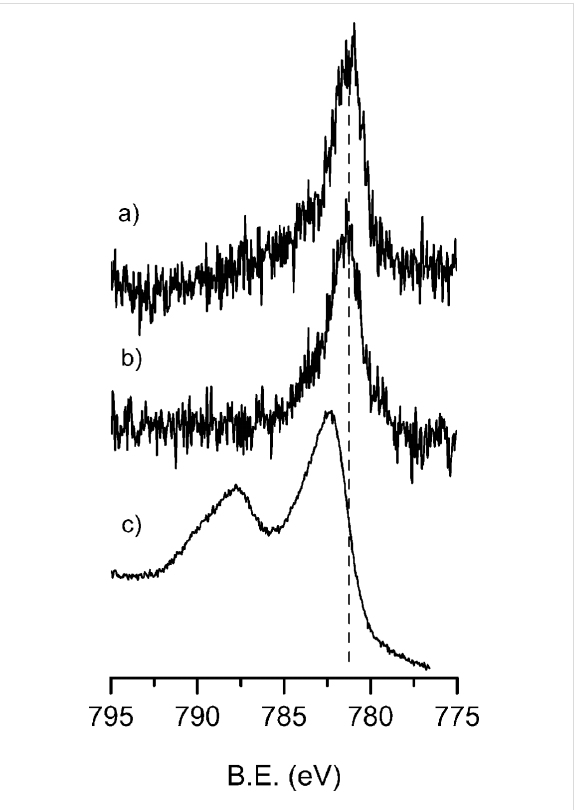
Figure 4: Co 2p3/2 XPS spectral region of Si-Co-Pc (a) and PSi-Co- Pc (b). The Co 2p3/2 region of CoCl 2 powder (c) has been added as